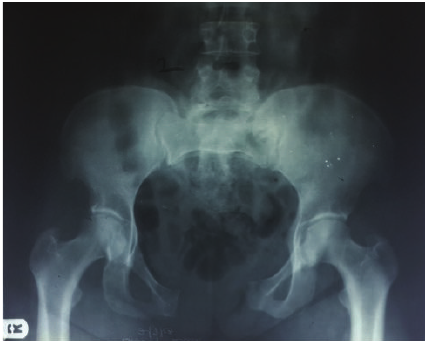
Figure 2: Pelvic X-Ray showing wide pubic diastasis, fractured left upper ischial ramus, and widened sacroiliac